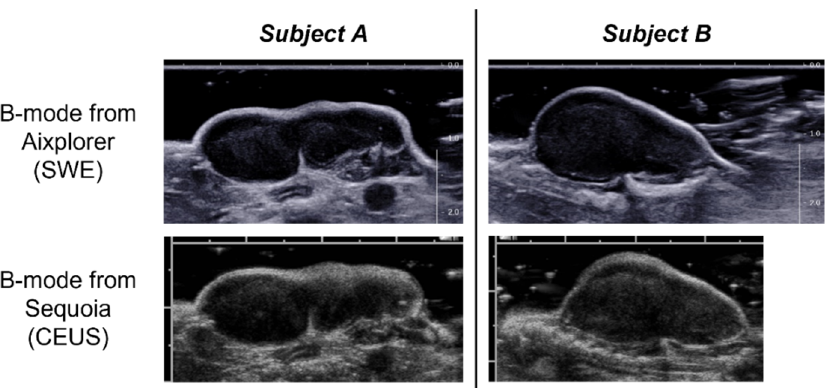
Figure 1. Example of the B-mode images along the longitudinal plane obtained with the Aixplorer ultrasound imaging system (used for ShearWave Elastography (SWE) imaging) and acquired at matched positions with the Sequoia system (used for dynamic Contrast-Enhanced Ultrasound (CEUS) imaging) for two different subjects. For the two imaging systems the distance between major tick marks is equal to 1